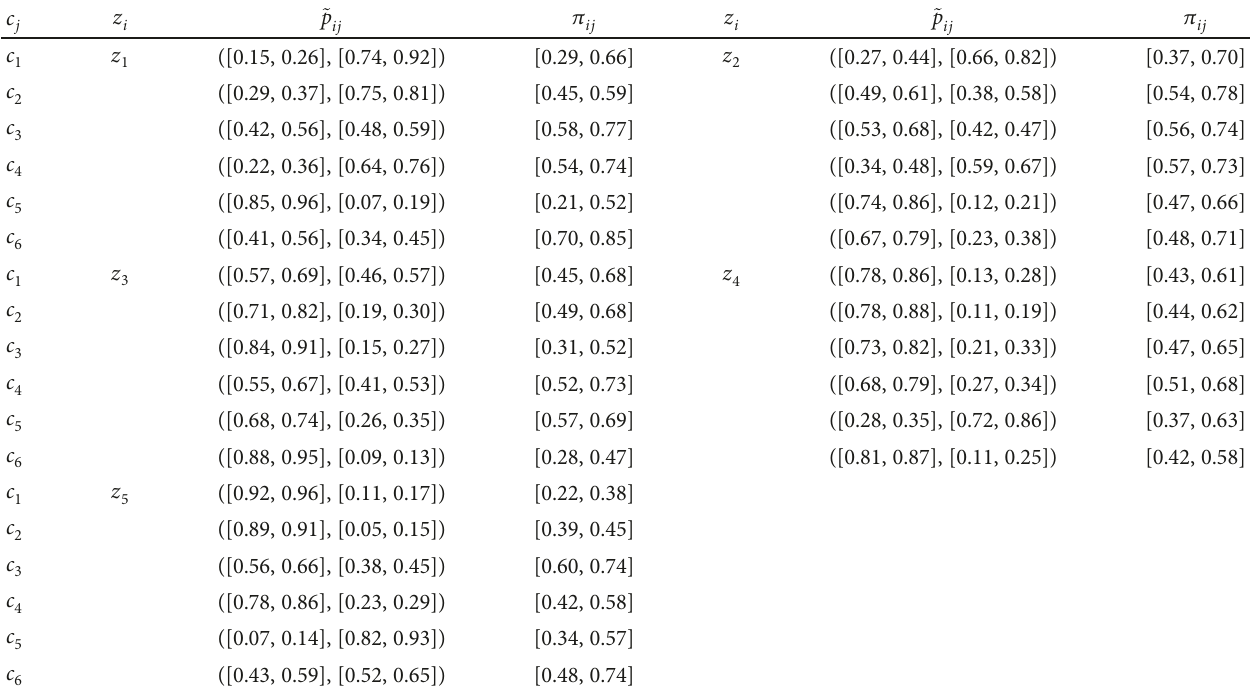
Table 4: IVPF evaluative ratings in the fi nancing decision of working capital